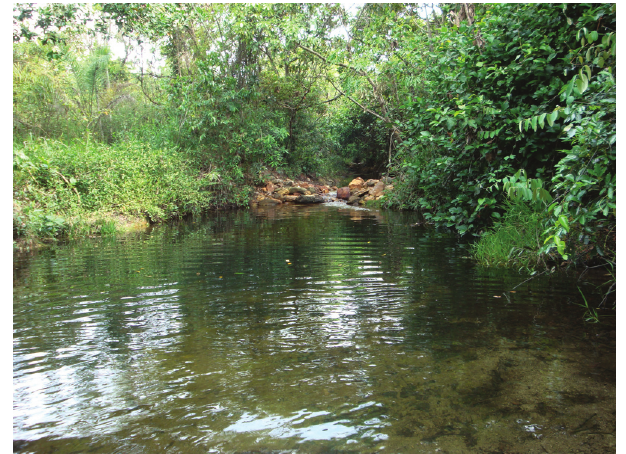
Fig. 6. Type locality of Moenkhausia dasalmas , tributary of rio das Almas, Cavalcante, Goiás,